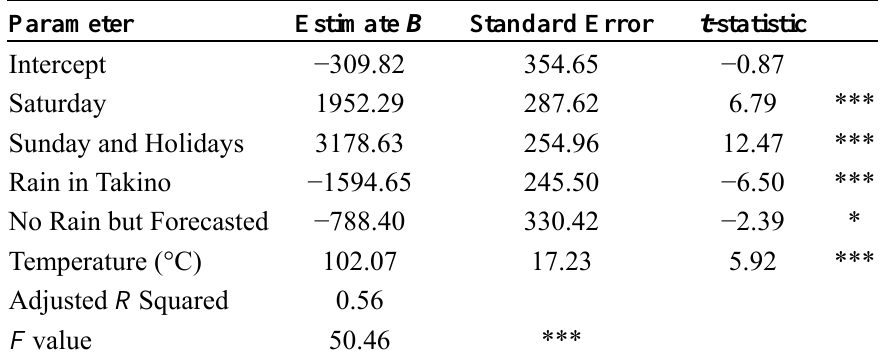
Table 5. Regression analysis for number of visitors in the green season in FY 2005, using day of the week and meteorological